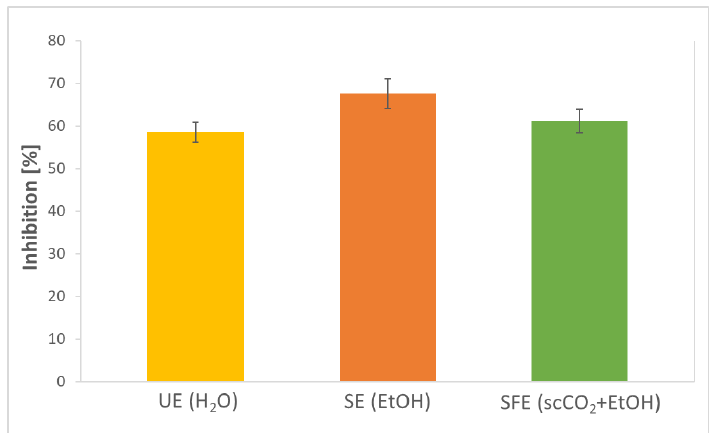
Figure 3. Antioxidant activities of AS extracts obtained by ultrasonic extraction (UE; solvent H 2 O), Soxhlet extraction (SE; solvent EtOH), and supercritical fluid extraction (SFE; solvent scCO 2 , co-solvent EtOH).